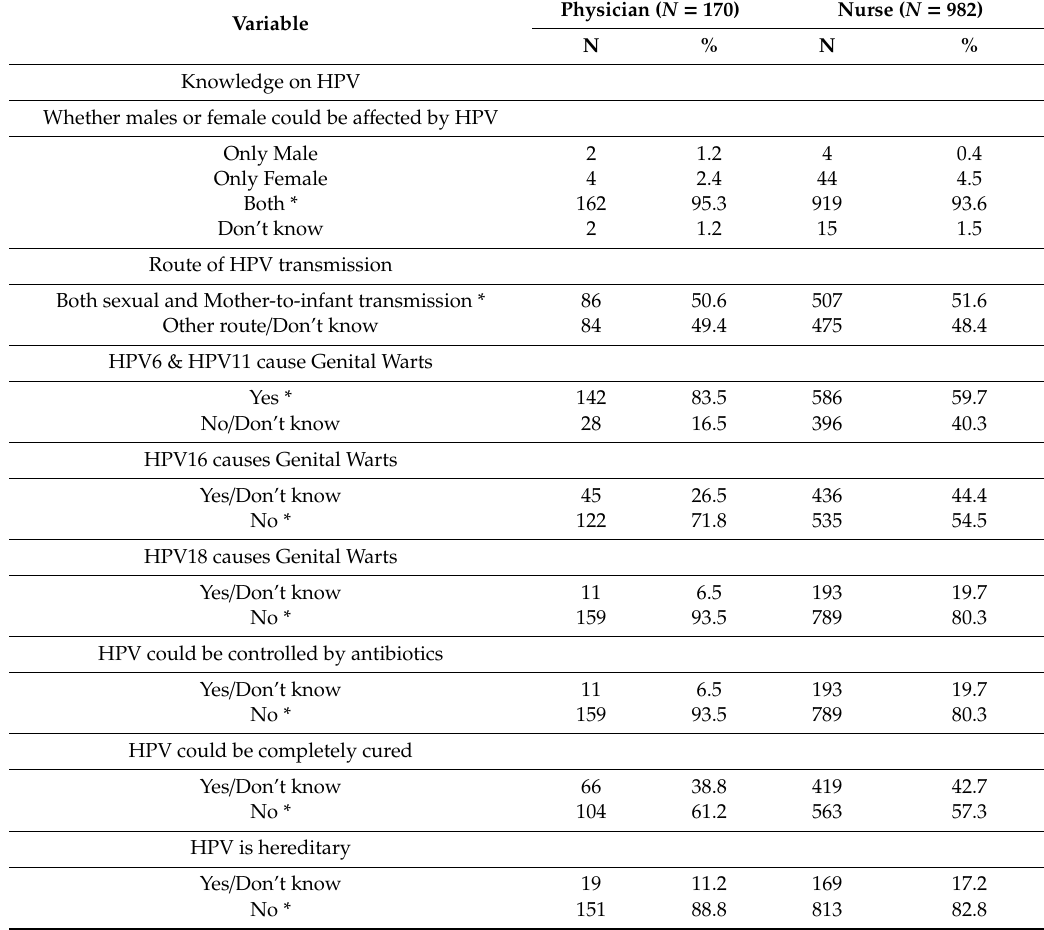
Table 3. Frequency distributions of variables related to HPV-related perceptions (N =